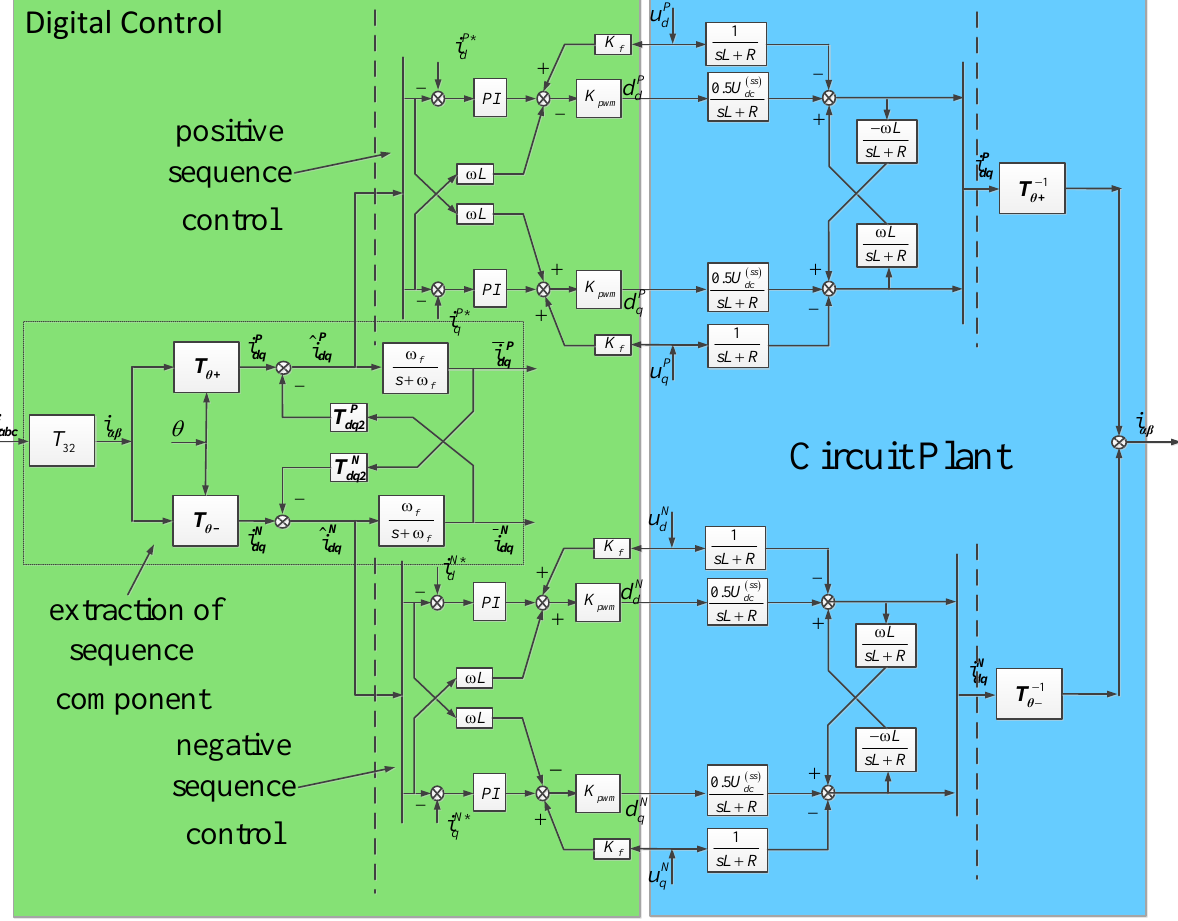
Figure 3. Control scheme for the grid-side